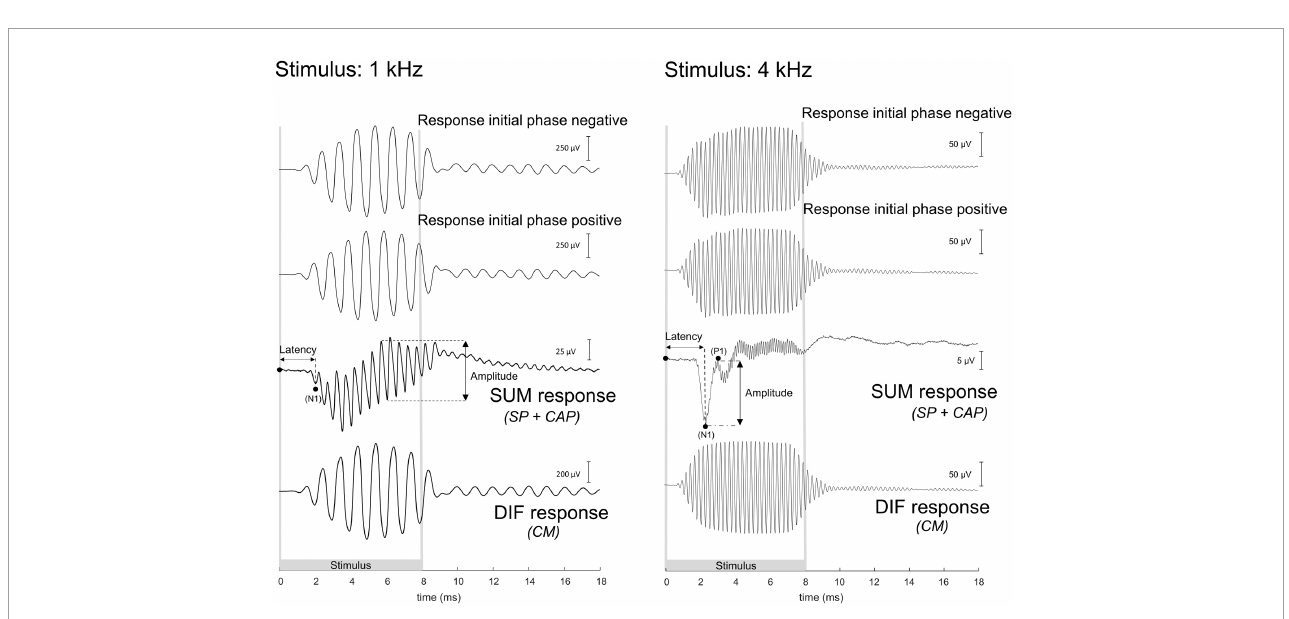
FIGURE3 These are example electrocochleography responses using the gold-ball electrode, before cochleostomy in the same animal (20JWA29), to a low and high frequency tone. Duration of the stimulus differed between the different frequencies, and the stimuli were presented in alternating polarity. The compound action potential (CAP) is derived from the SUM response by adding the two initial responses together. At frequencies between 0.25 and 1 kHz, in this instance at 1 kHz, the CAP latency is derived from the N1 peak, and the CAP amplitude was derived from the largest peak-to-peak amplitude of